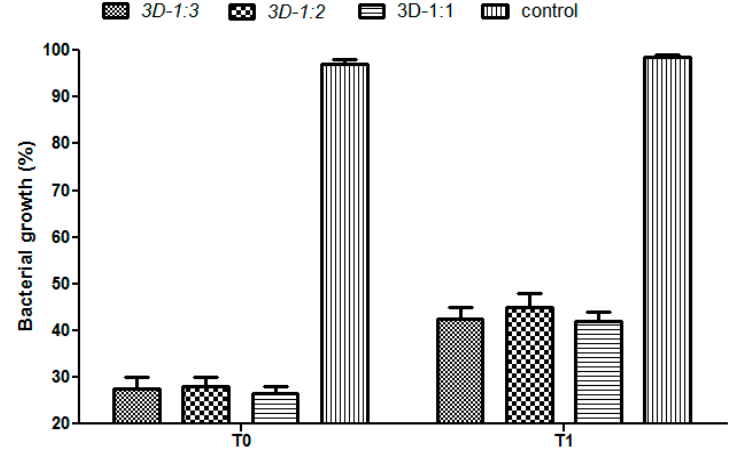
Figure 8. Antimicrobial activity of the 3D matrices quantified at T 0 and T 1 on S. aureus strain.